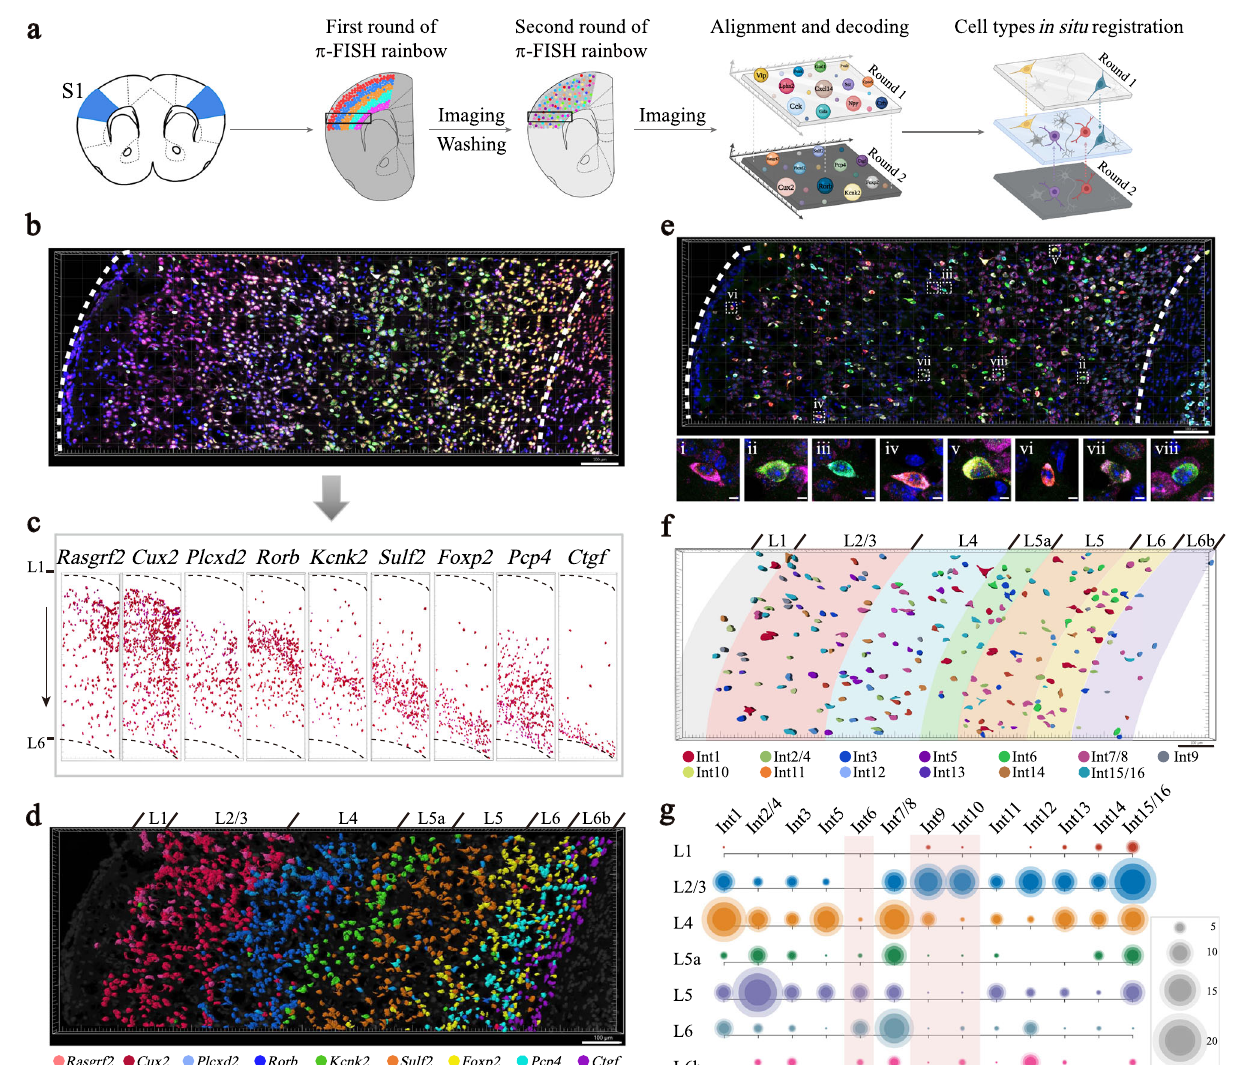
Fig. 2 | Spatial registration of neuron subclasses in mouse primary somato- sensorycortex(S1)by π -FISHrainbowmultiplexedinsitudetection.a Diagram ofspatialdecodingofpyramidalneuronandinterneuronsubclassesinmouseS1via two rounds of π -FISH rainbow hybridization and imaging. Nine excitatory neuron marker genes were detected in round 1, followed by signal wash-out and second- round hybridization of 12 interneuron marker genes. By combining two rounds of signals, spatial mapping of 13 interneuron subclasses in S1 were obtained. b Nine layer-speci fi c excitatory neuron marker genes ( Rasgrf2 , Cux2 , Plcxd2 , Rorb , Kcnk2 , Sulf2 , Foxp2 , Pcp4 ,and Ctgf )inS1weresimultaneouslydetectedby π -FISHrainbow. White dashed lines indicated the boundaries of the cortex. Scale bar, 100 μ m. c Decodingandmappingofsignalsfrom( b )showedthespatialdistributionofnine neuronmarkersintheL1 – L6layersoftheS1cortex.TheL1andL6ofthecortexinS1 are indicated by the black dashed lines. d π -FISH rainbow accurately reproduced thespatialdistributionoflayer-speci fi cmarkergenes,especiallyintheL5aandL6b